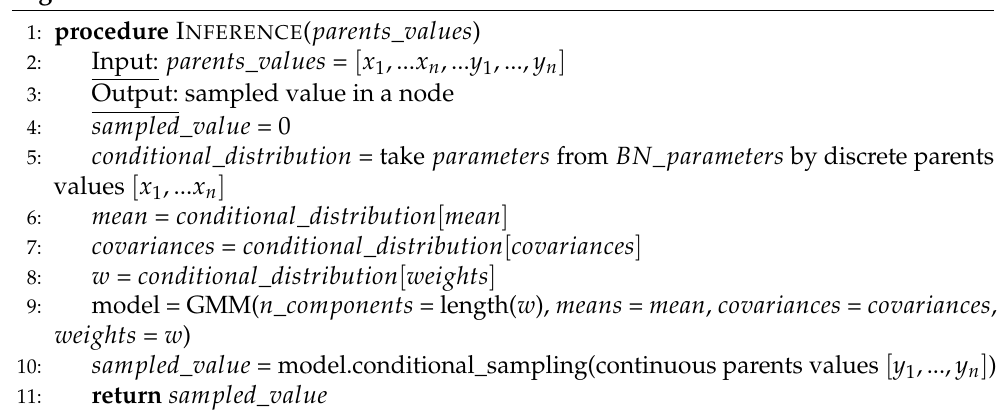
Algorithm 2 Inference for continuous nodes in BNs with